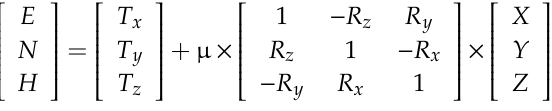
* Scanner positions are marked in Figure